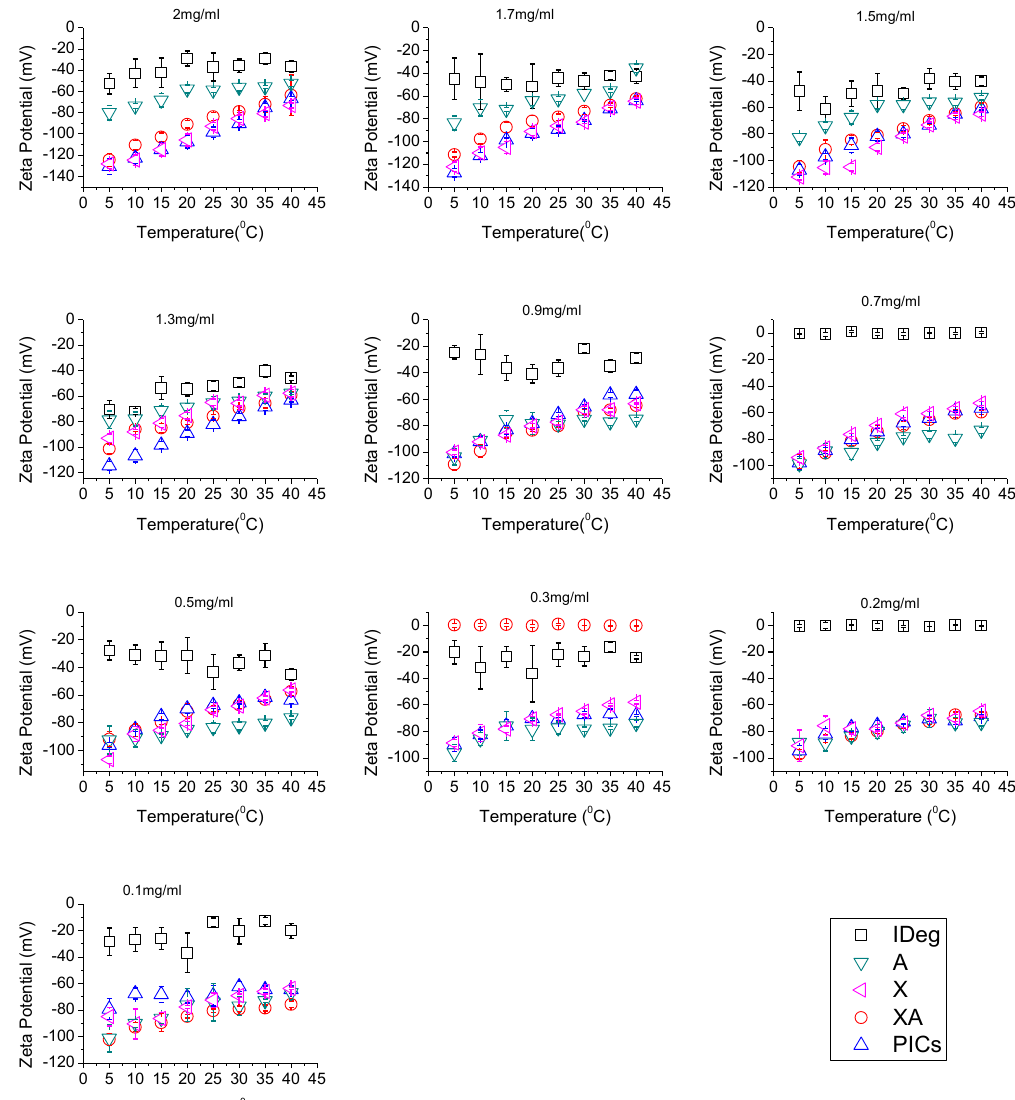
Figure 3. Zeta potential analysis of the Xanthan, Alginate, IDeg mixture of xanthan and alginate and PIC at a range of concentrations (0.1-2.0 mg/mL in 50 mM PBS, pH 7.0) and temperatures (5–40 °C). The mixture of XA displayed more negative surface charges than alginate on its own and less negative than xanthan on its own. PIC had -potential values very close to the xanthan on its own. IDeg in a pharmaceutical formulation exists as a di-hexamer with only one pole of the structure exposing positive charge of zinc ion, involved in di-hexamer formation [40]. Upon injection, in a physiological environment, this di-hexamer dissociates and changes conformation allowing Zn 2+ and amino acids located within to interact with other IDeg di-hexamers and to form long multi-hexamer chains in the subcutaneous tissue [44]. It is therefore possible that preparation of PIC dilutions in PBS buffer, resulted in the depletion of phenol and allowed certain conformational changes in IDeg that